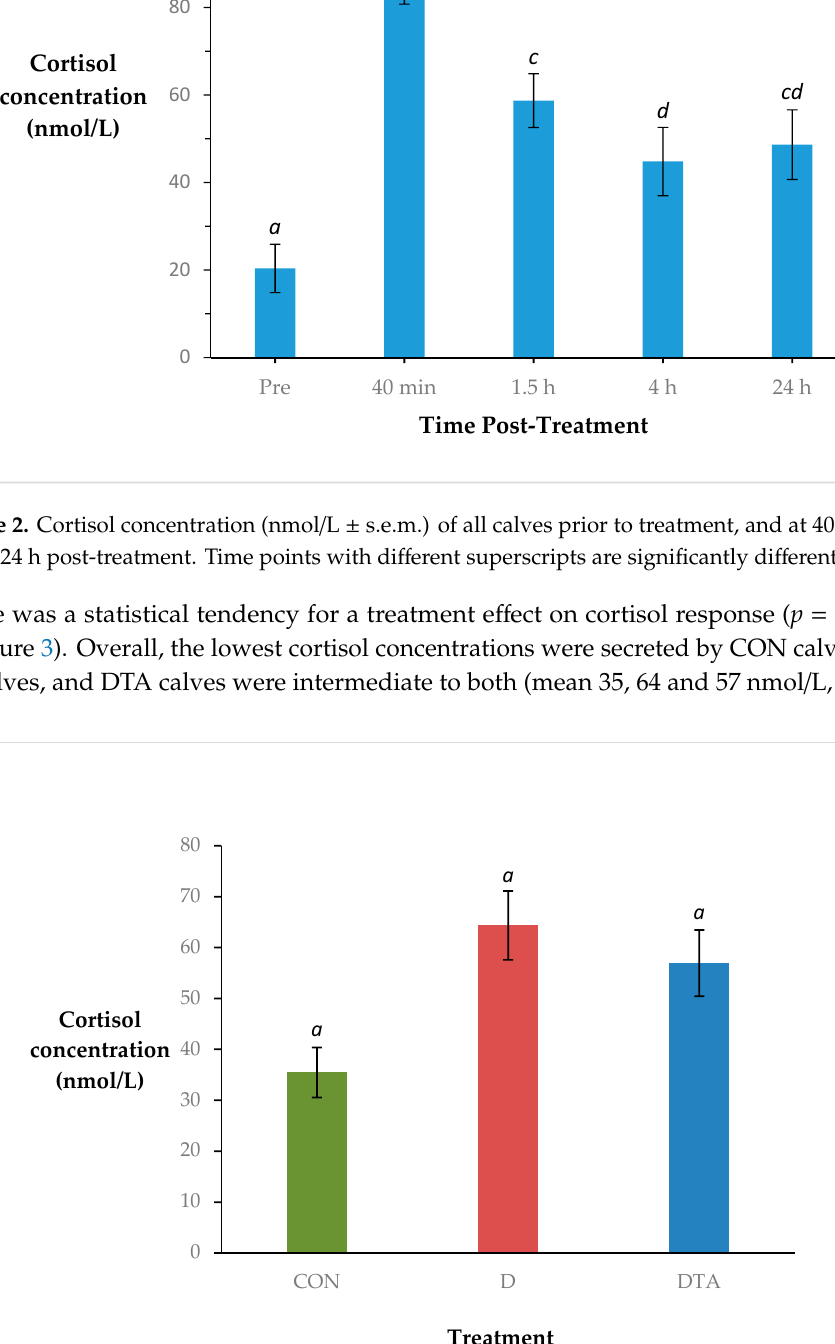
Figure 3. The effect of treatment (sham dehorning, CON; dehorning, D; dehorning with topical Figure 3. The e ff ect of treatment (sham dehorning, CON; dehorning, D; dehorning with topical anaesthetic, DTA) on cortisol concentration (nmol/L; ± s.e.m.). There was no significant effect of anaesthetic, DTA) on cortisol concentration (nmol / L; ± s.e.m.). There was no significant e ff ect of treatment on cortisol concentration ( p = 0.079). treatment on cortisol concentration ( p = Table 2. Area under the curve (AUC) (nmol/L per ha ± s.e.m.) for the plasma cortisol of calves subjected to sham dehorning (CON), dehorning (D), or dehorning with an application of topical anaesthetic (DTA). AUC 0–24 = area under curve from pre-treatment to 24 h post-treatment; AUC 0–40 min = area under the curve from pre-treatment to 40 min post-treatment; AUC 40 min–1.5 h = area under the curve from 40 min to 1.5 h post-treatment; AUC 1.5–4 h = area under the curve from 1.5 h to 4 h post- treatment; AUC 4–24 h = area under the curve from 4 h to 24 h post-treatment. Within a row, means without a common superscript differ significantly (P < 0.05). AUC Time Period